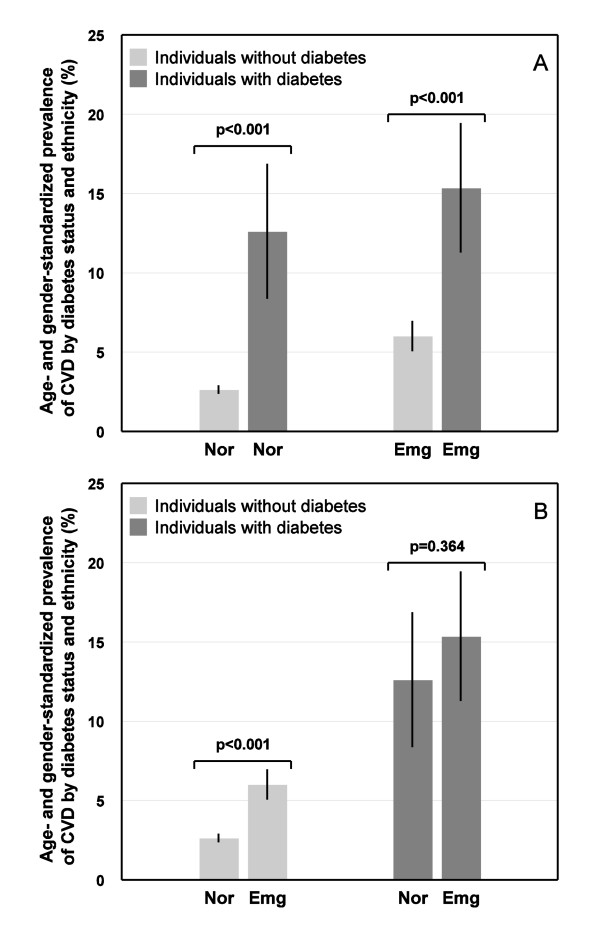
Prevalence (% with 95% CI) of cardiovascular disease (CVD) by diabetes status and ethnicity. Nor: Norwegians; Emg: the pooled ethnic minority group. Bars: CVD prevalence, |: 95% CI, p-value: difference in CVD prevalence between those with and without diabetes in Norwegians and the pooled ethnic minority group (A) and between Norwegians and the pooled ethnic minority group by diabetes status (B).